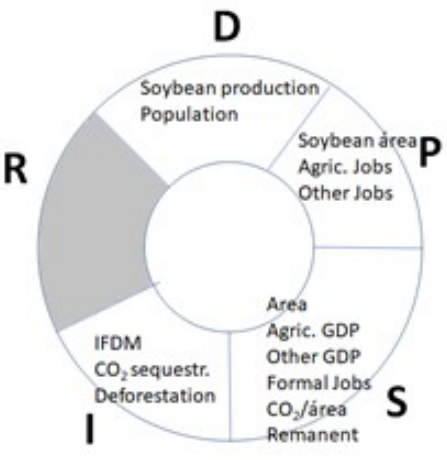
Figure 1. Indicators selected and its structuration their structural framework according to the DPSIR Framework. Source: